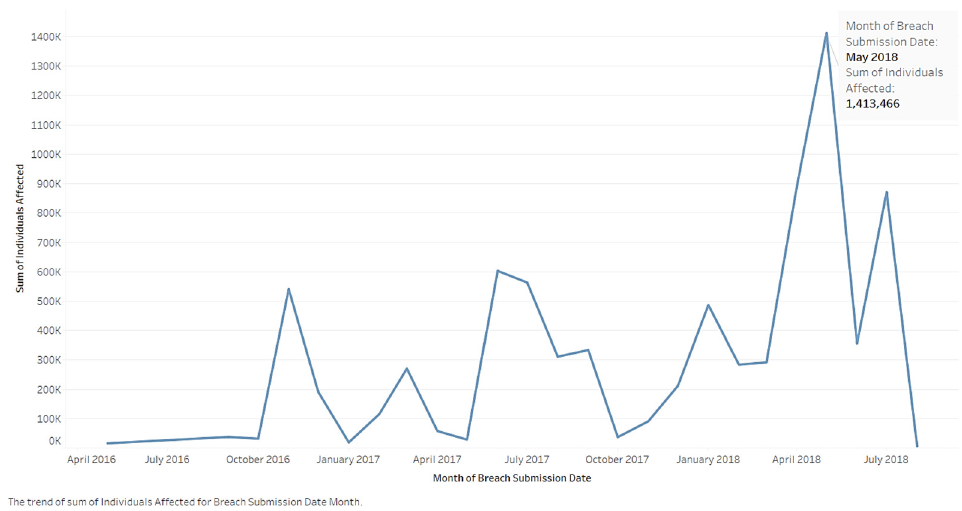
Figure 11. Trend of affected individuals by type of breach.